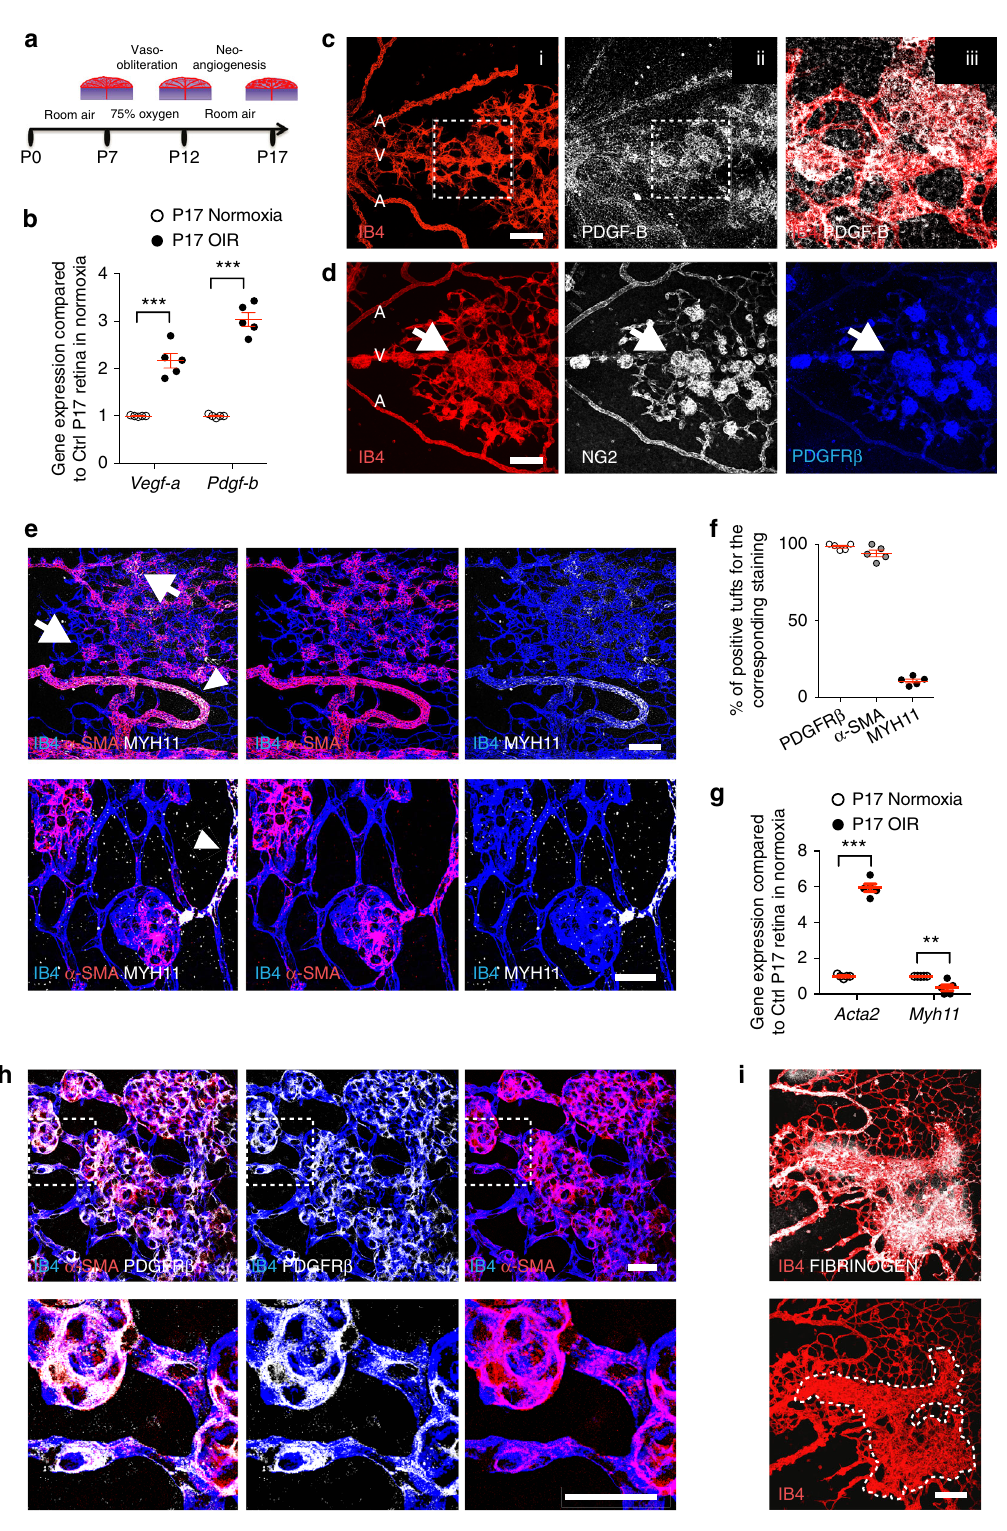
CreERT2 , and SMACreERT2 mice interbred with Rosa26-mTmG descendants. Tamoxifen injection at P6 and P7 activated